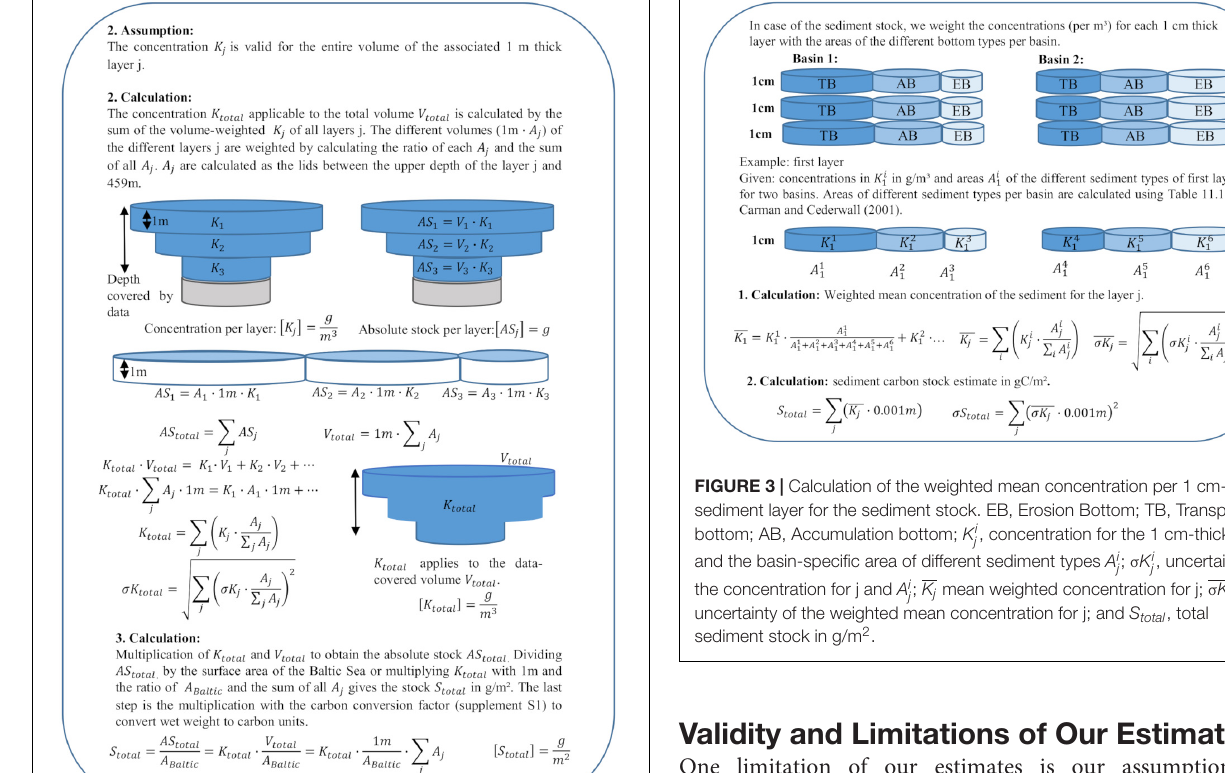
only grow on light exposed coastal seabed (mostly above 10 m).